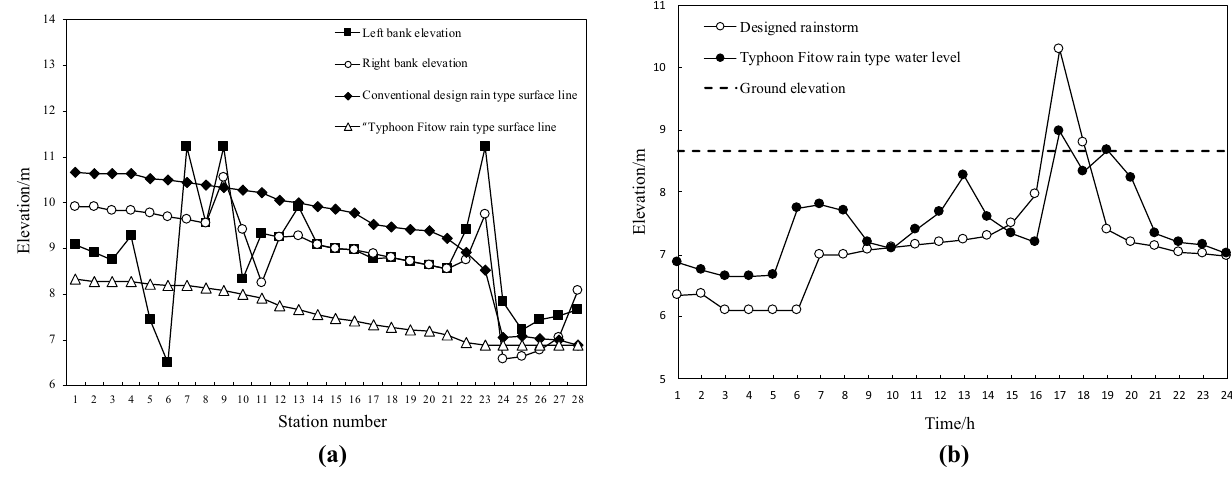
Fig. 3 a Calculated water surface curve under different rain patterns and b water level changes of Banshixi tributary